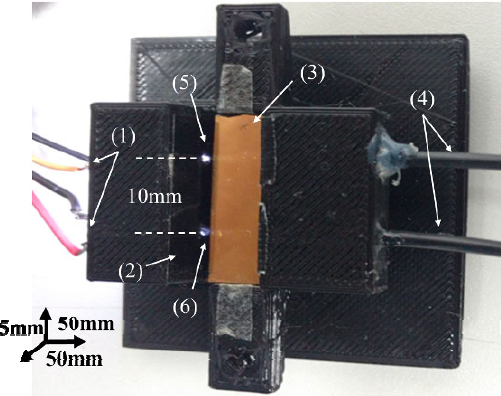
Fig. 8 Realized 3D printed multichannel SPR system with components